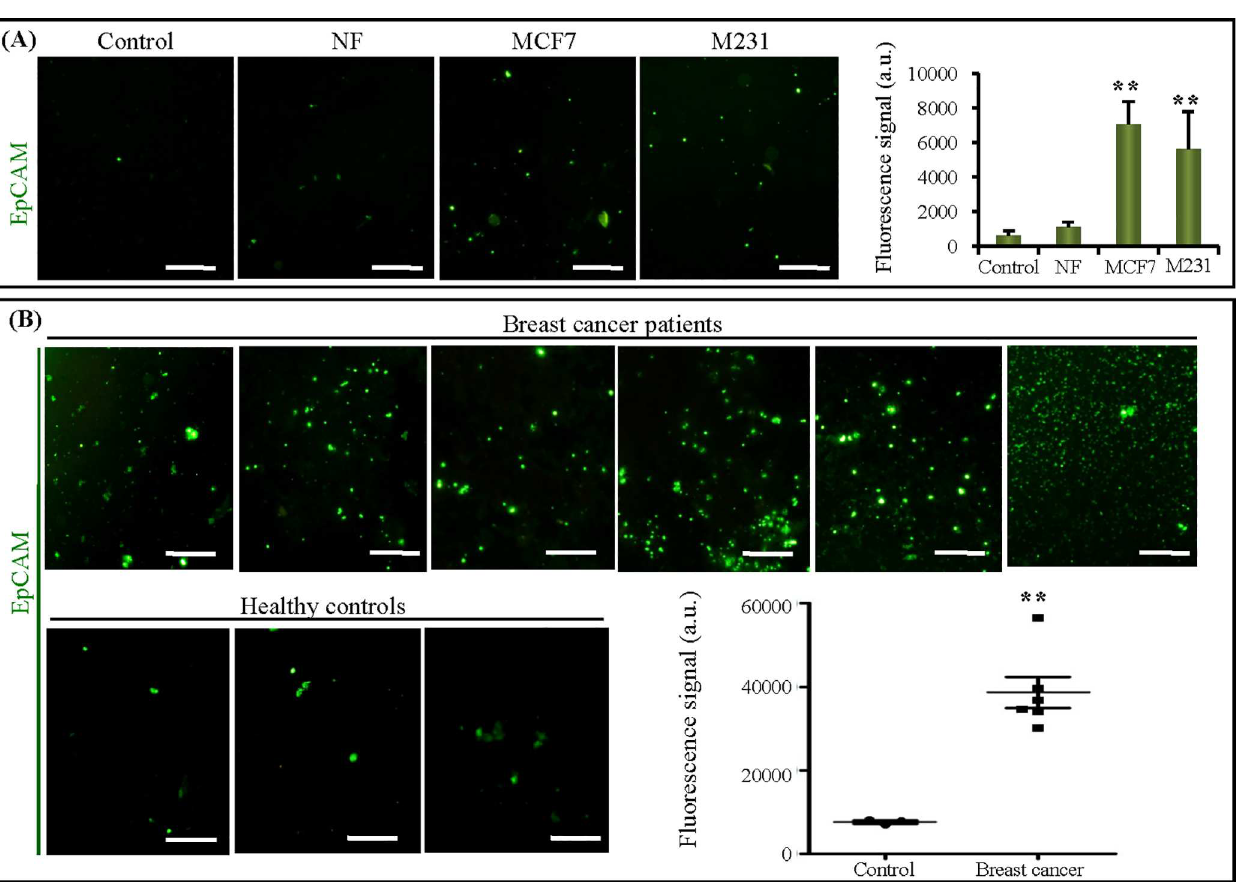
Fig 4. Quantification of EpCAM-positive exosomes from breast cancer cell lines and clinical patients. (A) Images and quantification of captured EpCAM-positive exosomes from Ctr, NF, MCF7 and M231 culture medium. (B) Images of and quantification of captured EpCAM- positive exosomes from plasma samplesof breast cancer patients (6 cases) and healthy controls (3 cases). * , p < 0.05; ** , p < 0.01. The scale bars represent 50 μ m.